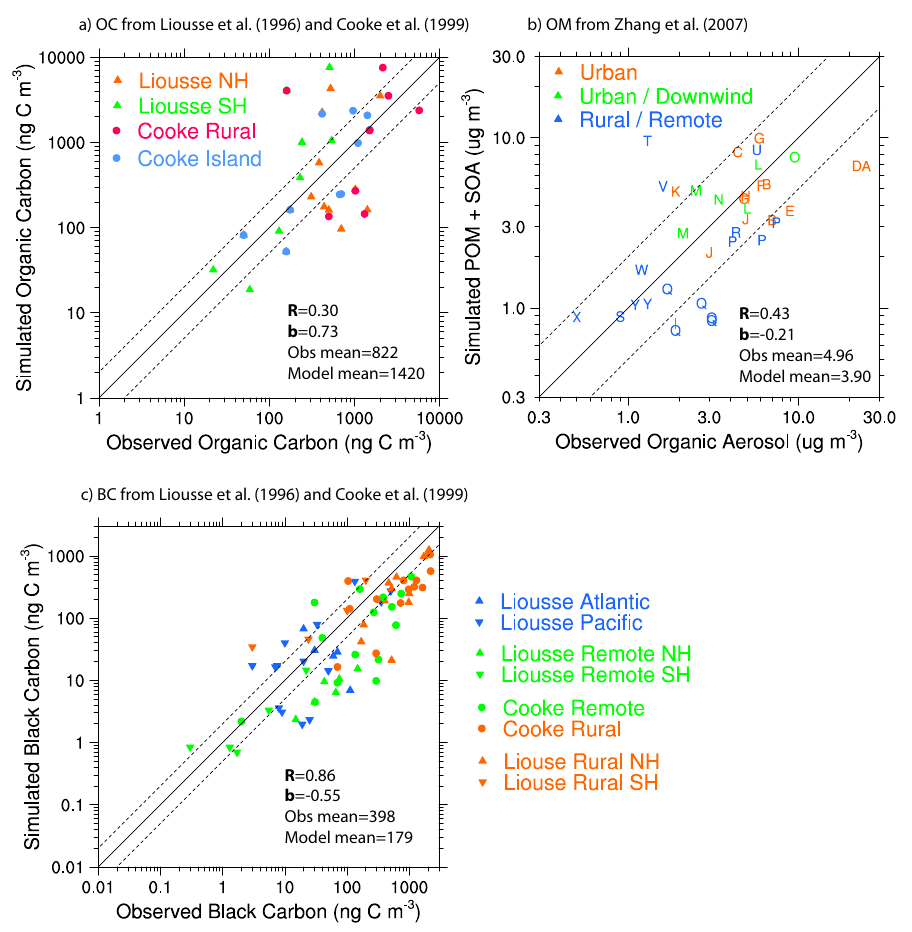
Fig. 12. Annual average simulated BC and OC concentrations versus observations from Liousse et al. (1996), Cooke et al. (1999), and Zhang et al. (2007): (a) OC concentrations from Liousse et al. (1996) and Cooke et al. (1999); (b) OCM concentrations from Zhang et al. (2007); (c) BC concentrations from Liousse et al. (1996) and Cooke et al. (1999). An OC/OM ratio of 1.4 is used to convert simulated OM (POM+SOA) to OC in (a) . Model mean (“Model mean”), observational mean (“Obs mean”), normalized model mean bias (“b”) and the correlation coefficient between model and observations (“R”) are shown in each